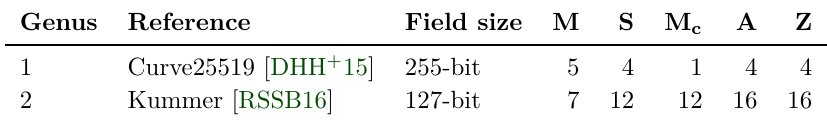
Table 1: Comparison of required field operations for point addition and point doubling: multiplication ( M ), squaring ( S ), constant multiplication M c , addition ( A ), and subtrac- tion ( Z